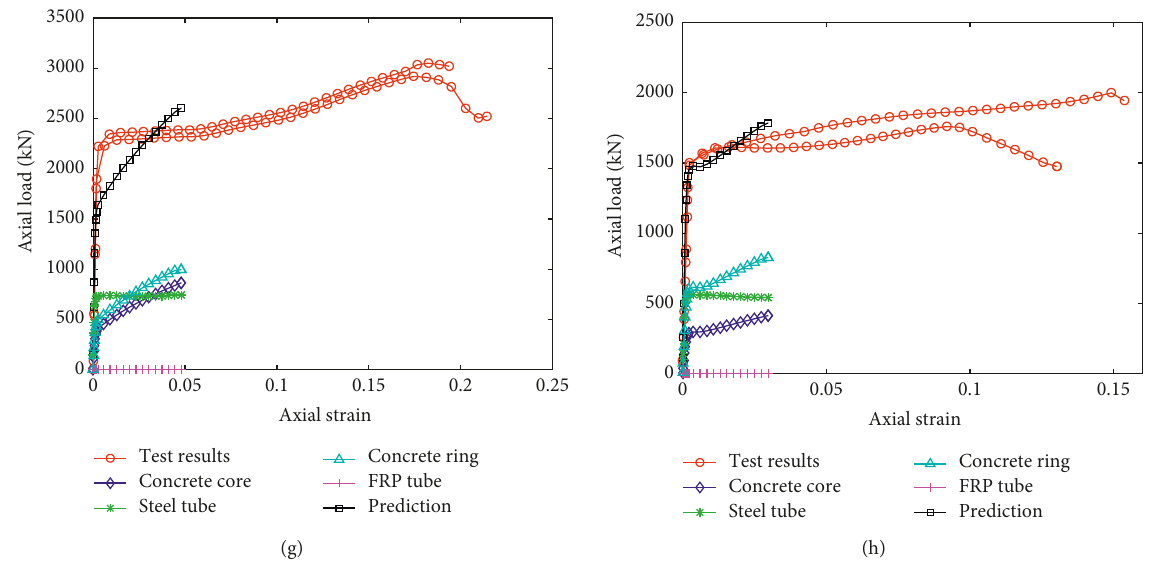
Figure 18: Comparisons of axial load-strain curves with Wang’s [32] model. (a) A4-F80-M1,2. (b) B4-F80-M1,2. (c) A4-F60-M1,2. (d) A8- F60-M1,2. (e) B4-F60-M1,2. (f) A4-F45-M1,2. (g) A8-F45-M1,2. (h) B4-F45-M1,2.